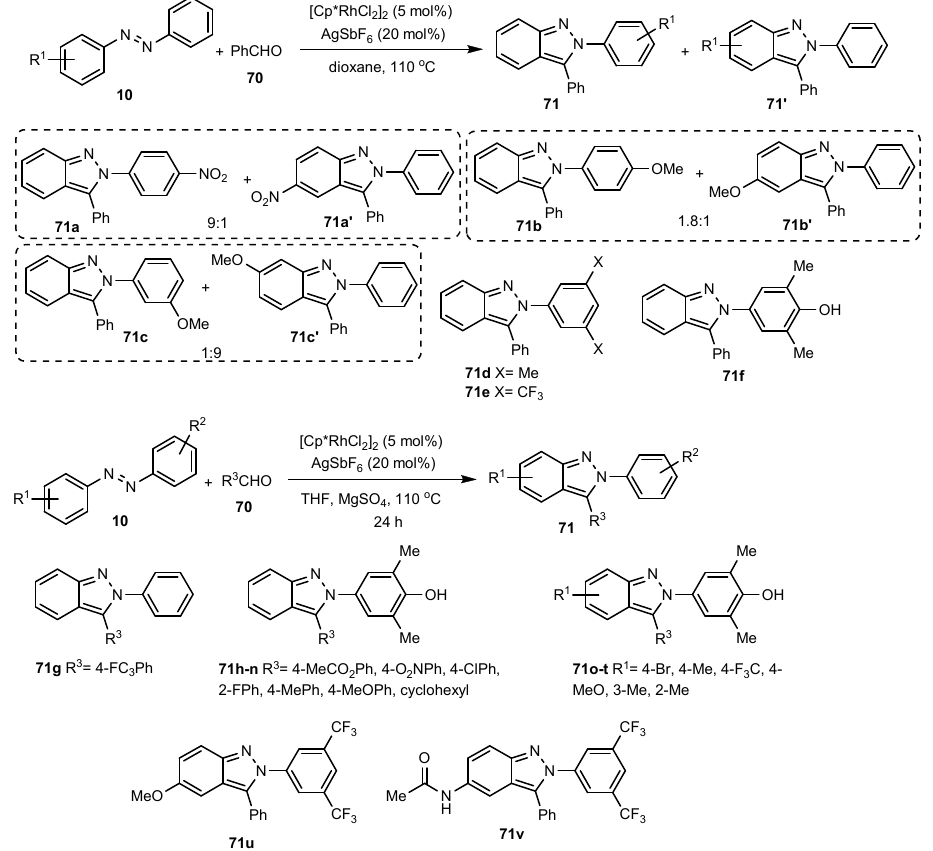
Scheme 19. A synthetic route for the preparation of indazole derivatives 71 via C − H bond function- alization and cyclative